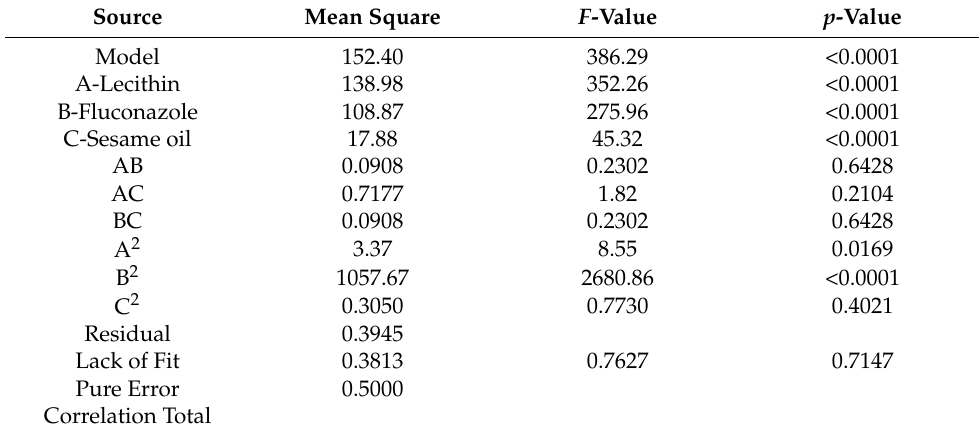
Table 4. Statistical outcome (ANOVA) of the interactions of three independent variables on the EE% of the